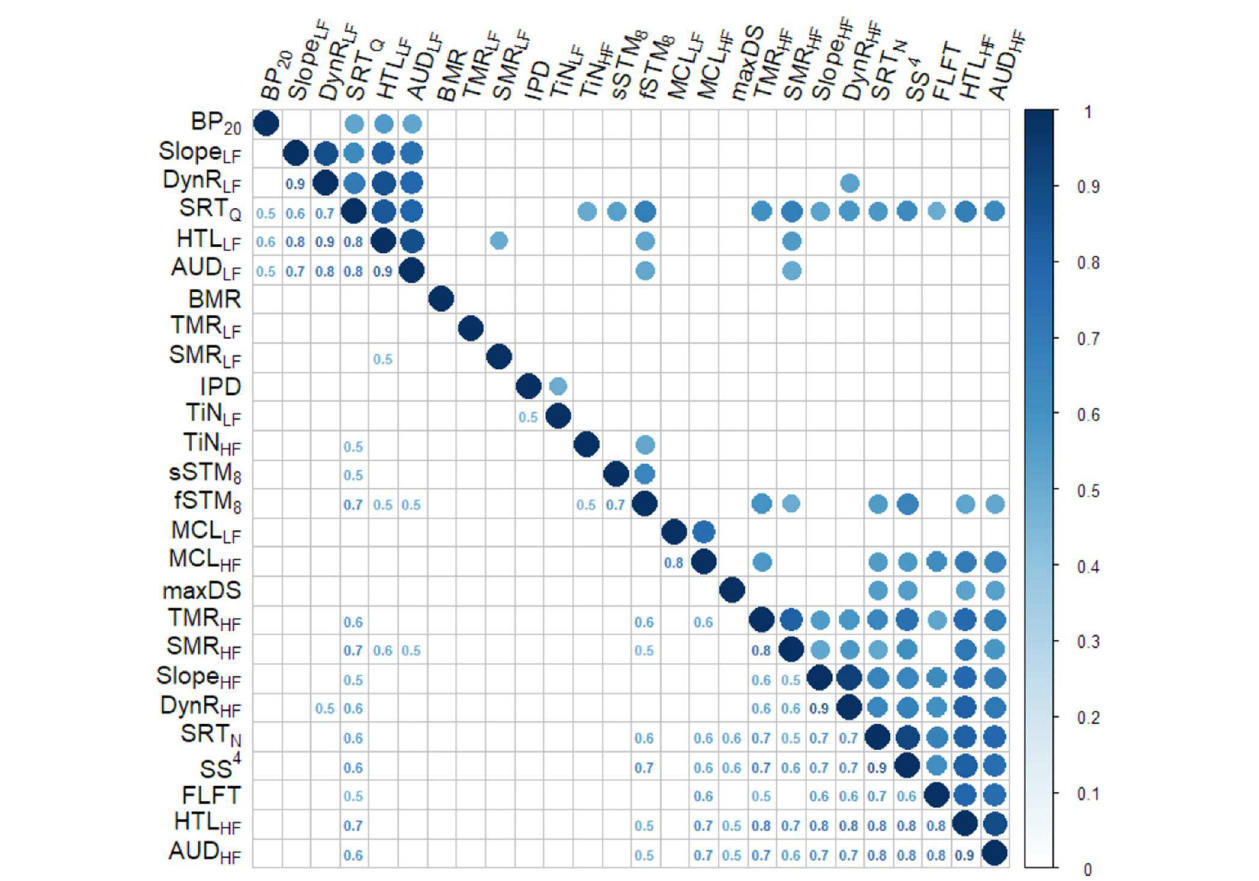
FIGURE 4 | Correlation plot of the data set BEAR3. The upper part shows the significantly correlated variables as colored circles. The lower panel shows the numeric correlation